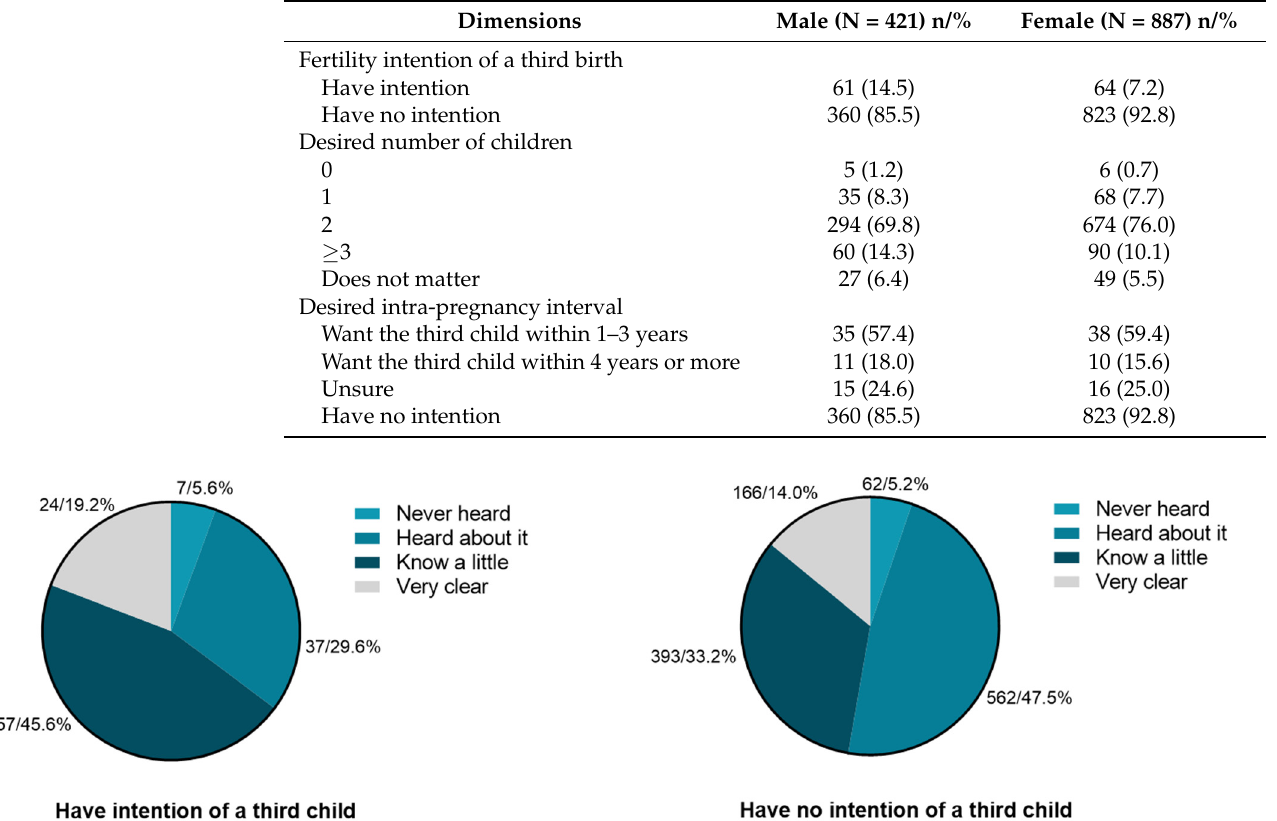
Table 2. Measurement of fertility intention (N = 1308).